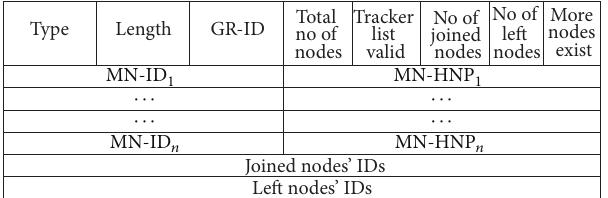
new MAG ID. Group ID is removed from the PBCE entries of the nodes which are no longer a part of mobile network. MR 2 resets its network tracker list to start mobile node’s tracking